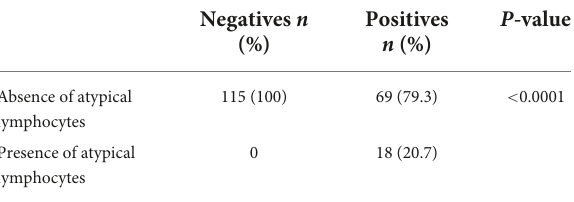
P -value Negatives n Positives n (%) (%)